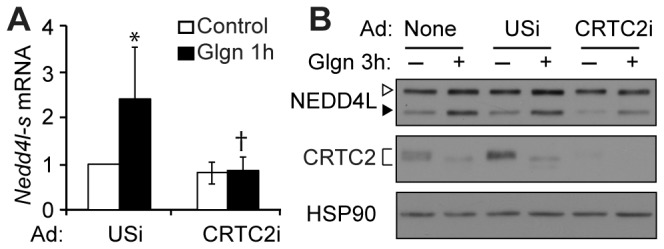
CRTC2 is required for Nedd4l short isoform regulation.Primary hepatocytes were infected with adenovirus encoding unspecific shRNA (Ad-USi) or CRTC2-specific shRNA (Ad-CRTC2i) and treated with glucagon (100 nM). (A) Nedd4l-short mRNA expression, expressed as mean fold change to GFP control ± stdev (n=4 samples averaged among three independent experiments). *p<0.05 to unstimulated, †p<0.05 to glucagon-treated Ad-USi-infected. (B) Western blots of NEDD4L isoforms, CRTC2 and HSP90 loading control (representative of four experiments). Filled arrowheads, NEDD4L-short; open arrowheads, NEDD4L-long; bracket, phospho- and dephospho-CRTC2.